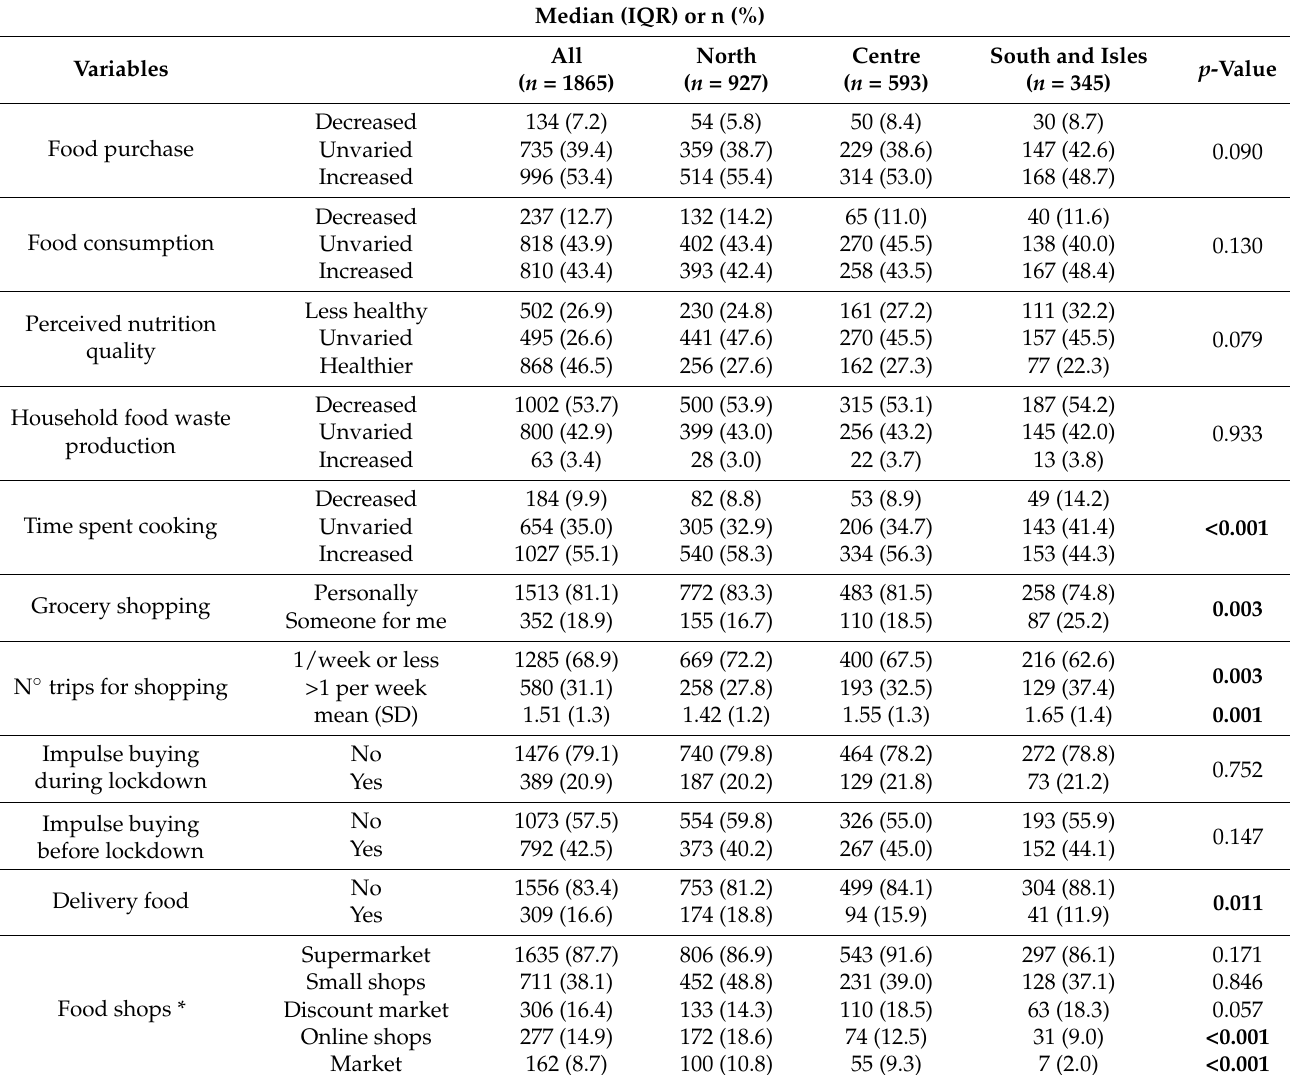
Table 2. Food purchase and consumption habits stratified by geographical area: Descriptive and Chi-square analysis.